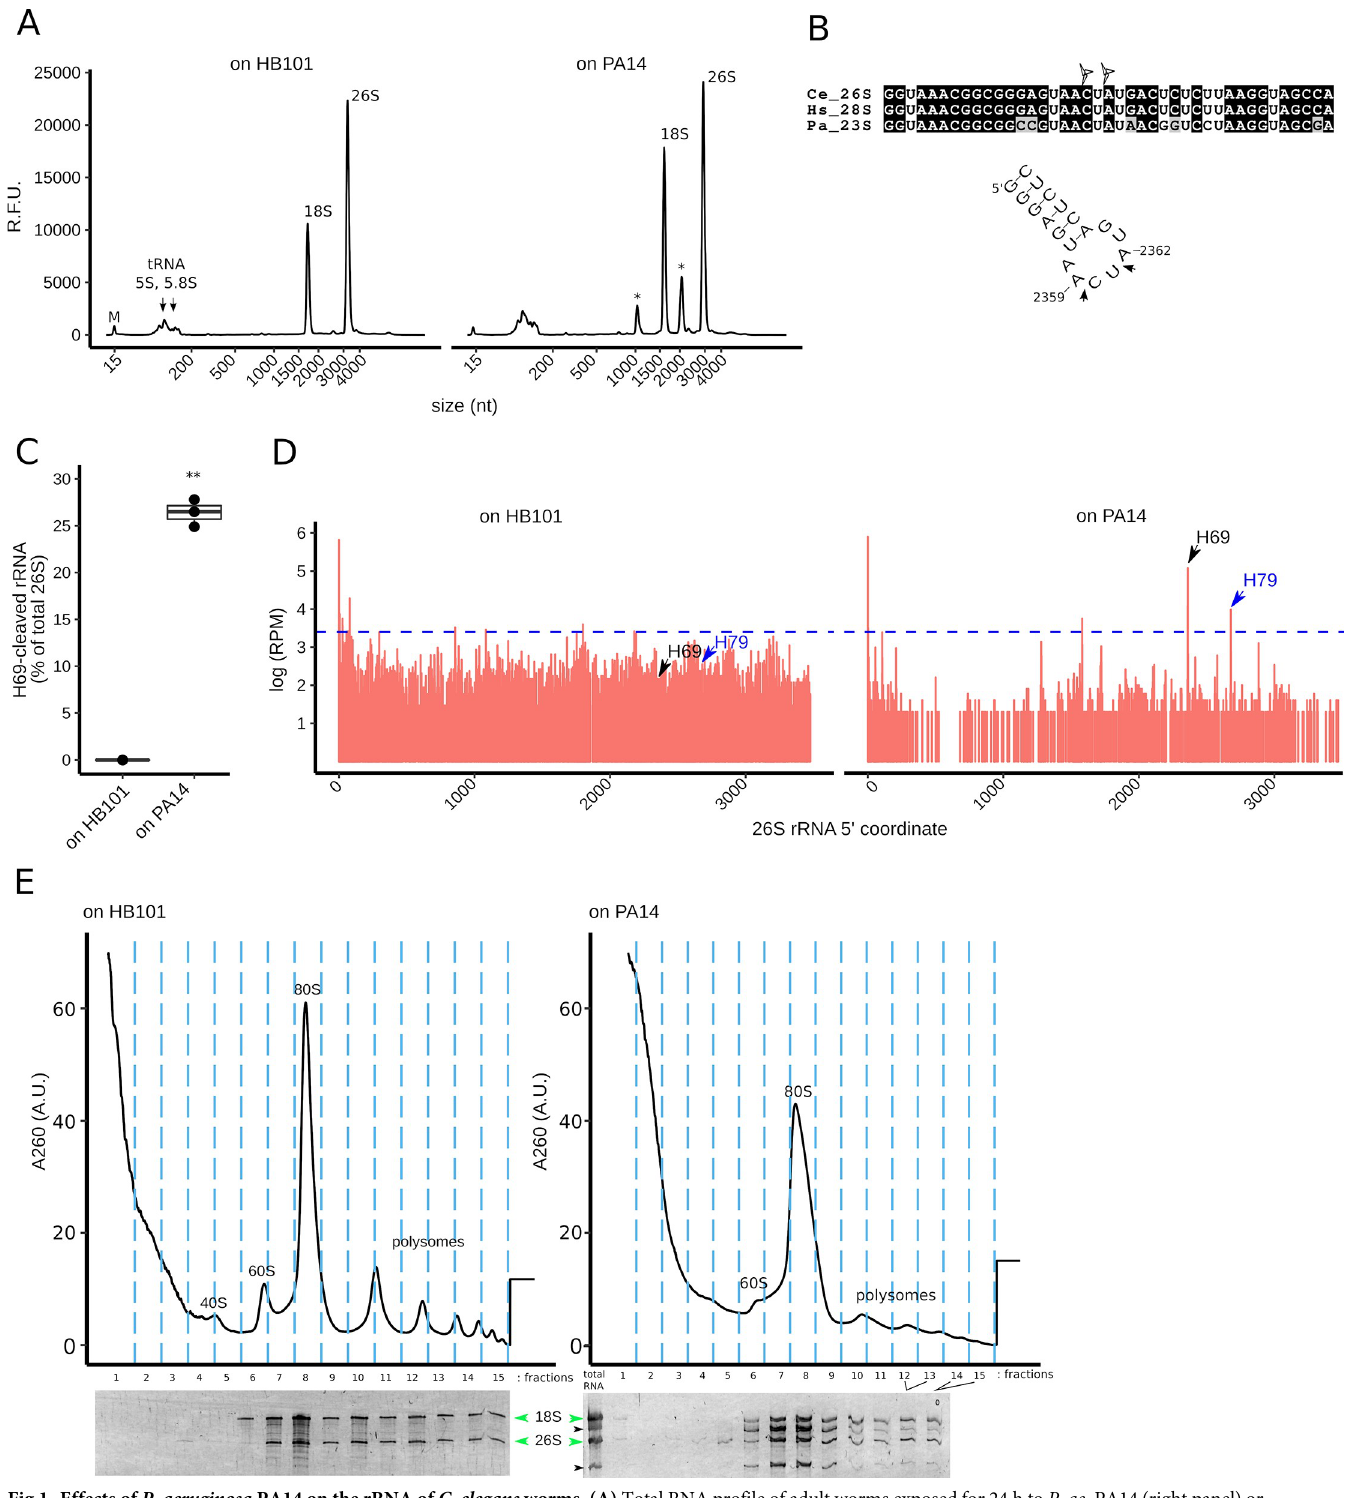
Fig 1. Effects of P . aeruginosa PA14 on the rRNA of C . elegans worms. (A) Total RNA profile of adult worms exposed for 24 h to P . ae . PA14 (right panel) or Escherichia coli HB101 (left panel). Asterisks indicate the 2 most abundant bands that appear upon PA14 exposure. “M” indicates a 15-nt marker used in the electrophoretic separation system. (B) Top: 26S rRNA alignment of C . elegans ( Ce ), Homo sapiens ( Hs ), and P . aeruginosa ( Pa ) sequences around the cut sites (triangles) that define the 2 bands indicated on (A). Bottom: secondary structure of the region comprising the cut sites (arrowheads). The hairpin structure corresponds to the 26S